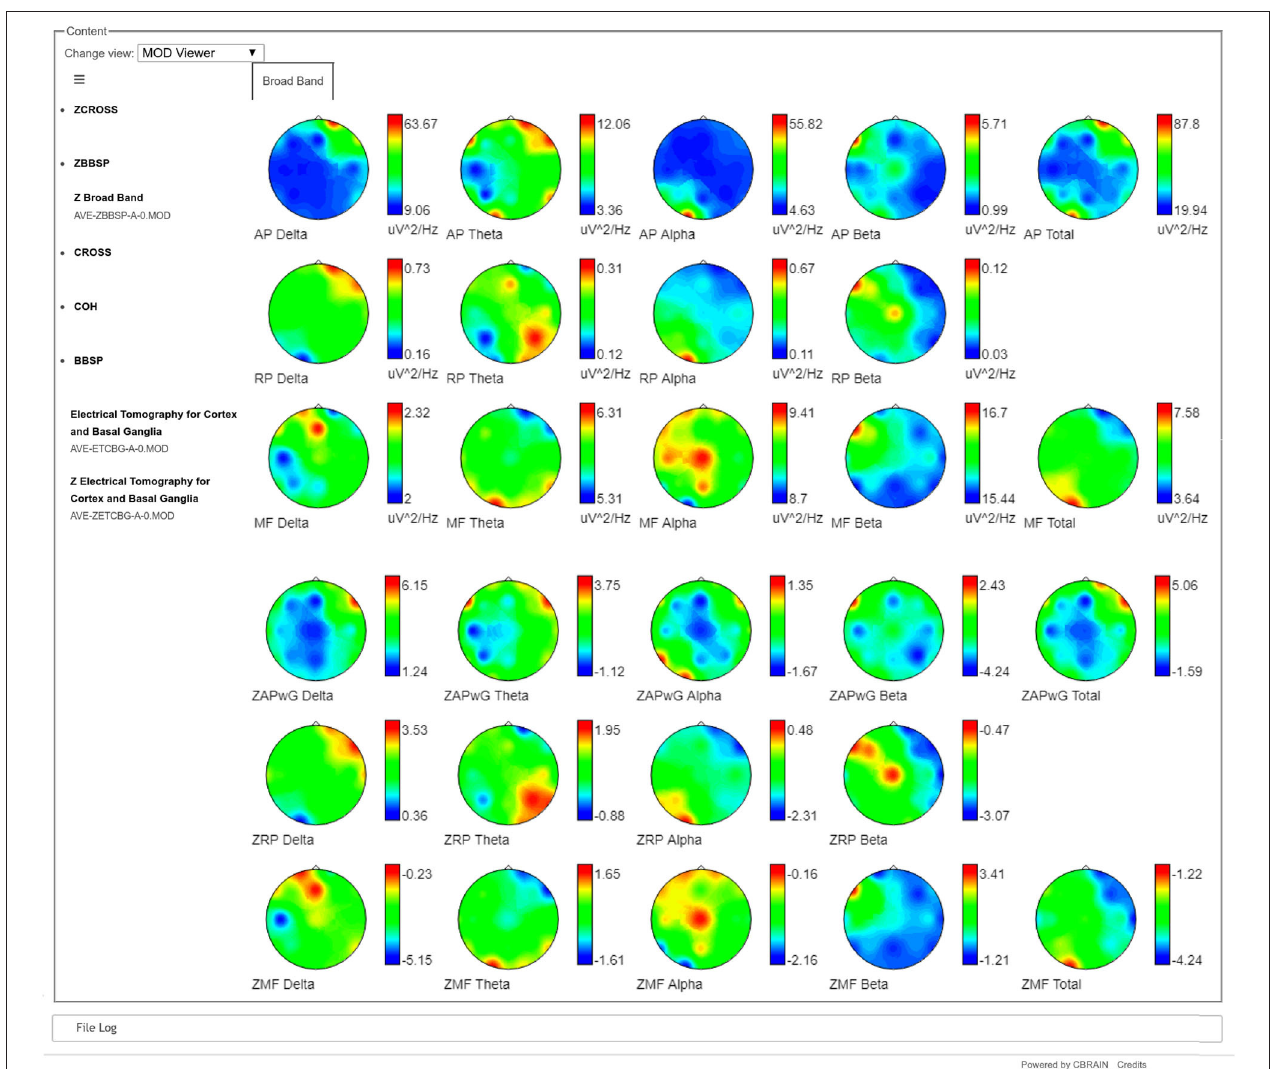
FIGURE 2 | Broad Band Model visualization of raw and Z spectra. The three upper rows show the raw Absolute Power (AP), Relative Power (RP), and Mean Frequency (MF) of the individual’s spectra respectively. The three bottom lines show the corresponding Z scores, calculated against the Cuban Normative Database. The red color in the raw Absolute Power maps (first row) show the same frontal and temporal higher slow activity (Delta and Theta) that was observed in Figure 1 in the right hemisphere, while the Alpha activity is concentrated in the contrary part of the contrary hemisphere (O1). The blue colors show the leads where the amplitude of the raw activity is smaller. In the case of the Z maps, the red colors indicate areas of excess of activity regarding the values of the normative database and blue colors indicate decrements of activity compared to the normative database. For example, the red colors of the Delta Z Absolute Power in the 4th row show values which are more than 6 standard deviations above the normative values. Meanwhile, in the same row, blue colors show values which are 4 standard deviations below the normative values in the parietal leads of the right